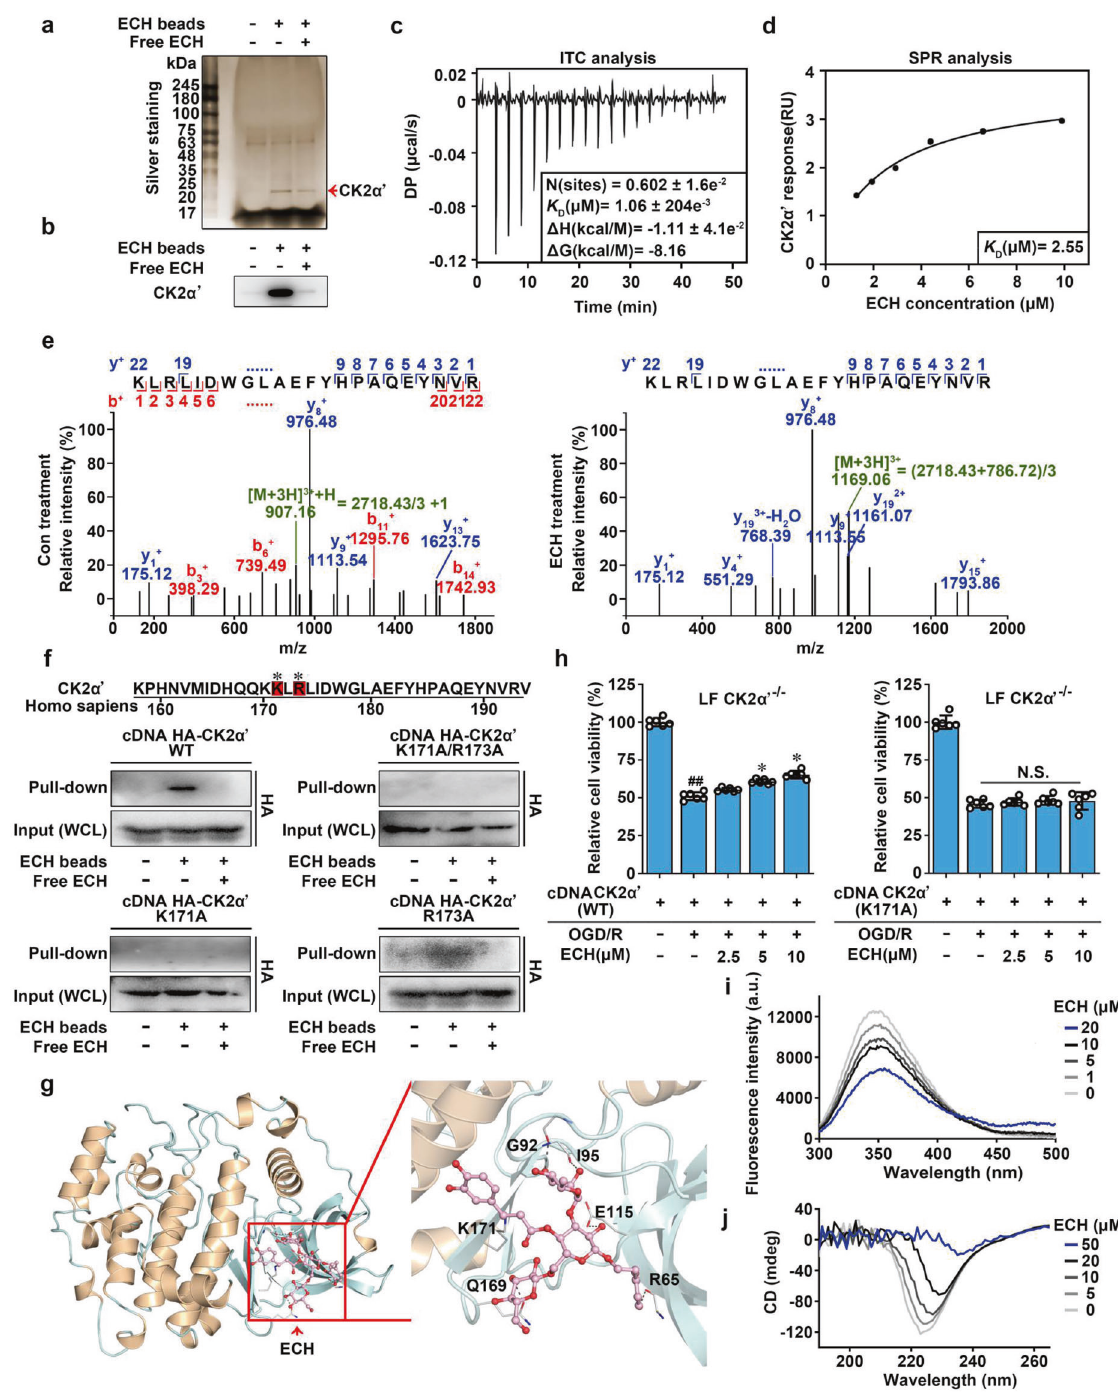
Fig. 2 Casein kinase 2 α ′ is a direct cellular target of ECH. a Identi fi cation of cellular target of ECH using pull-down technology coupled with LC – MS/MS. PC12 lysate was incubated with control beads or ECH beads. The binding proteins were detected by SDS – PAGE, followed by silver staining and LC – MS/MS analysis. b The binding proteins were detected by western blot. c Calorimetric titration of ECH with CK2 α ′ . d ECH interacted with CK2 α ′ , which was detected by SPR analysis. e LC – MS/MS analysis of covalently modi fi ed peptide by ECH (10 μ M) in CK2 α ′ protein. f CK2 α ′ (K171A), but not CK2 α ′ (R173A) is responsible for ECH binding to CK2 α ′ . HEK293T cells were transfected with HA-tagged CK2 α ′ and its mutant plasmids. The Lys and Arg labeled by * were potential modi fi cation sites. g Docking analysis of ECH covalent binding mode to CK2 α ′ . h ECH increased cell viability against OGD/R-induced injury in CK2 α ′ − / − lung fi broblasts (LF), which were supplemented with CK2 α ′ but not CK2 α ′ mutant plasmids. i Fluorescence spectroscopy analysis of the conformational change of CK2 α ′ with ECH. j CD spectra analysis for ECH-mediated CK2 α ′ conformational change. Data are expressed as the mean ± SD. ## P < 0.01 vs. control group, * P < 0.05, ** P < 0.01 vs. OGD/ R group